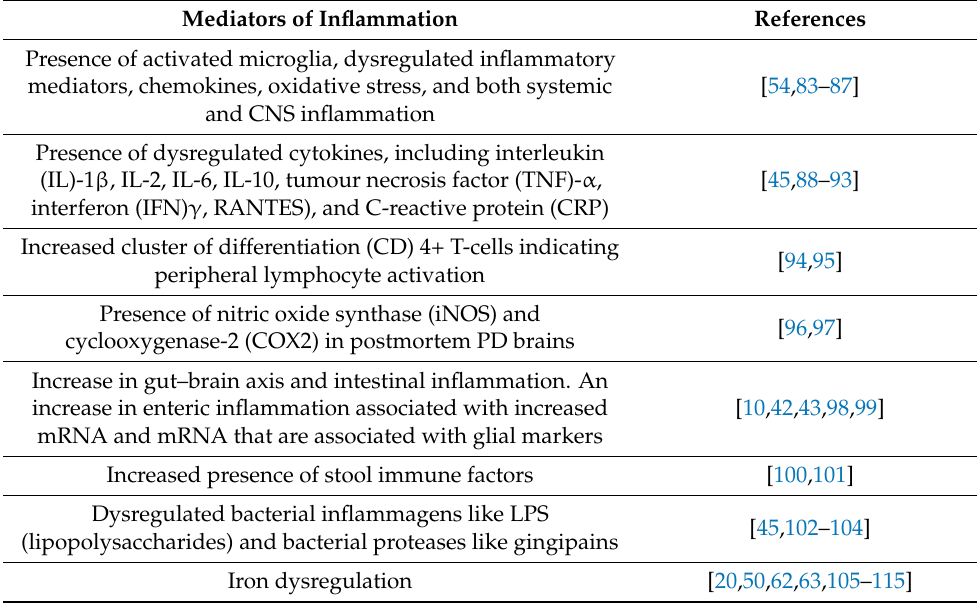
Table 1. Selected references showing evidence of systemic mediators and iron dysregulation of inflammation in Parkinson’s